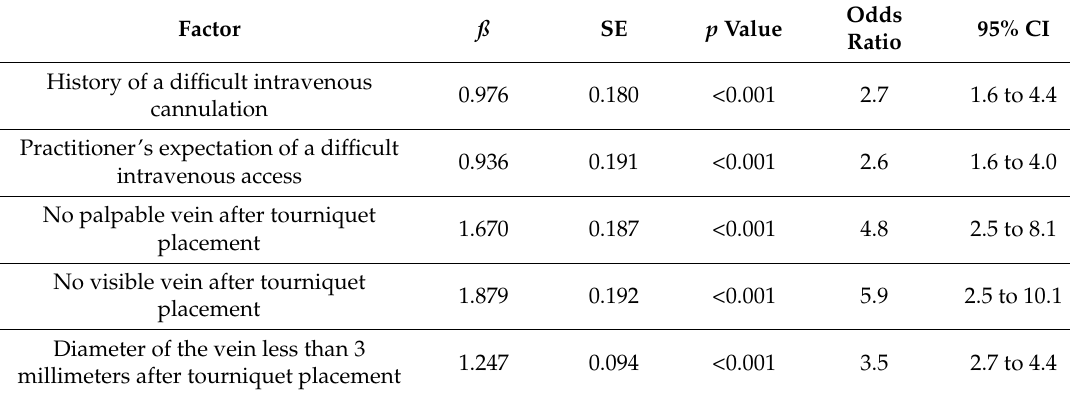
Table 3. Multivariate regression analyses.